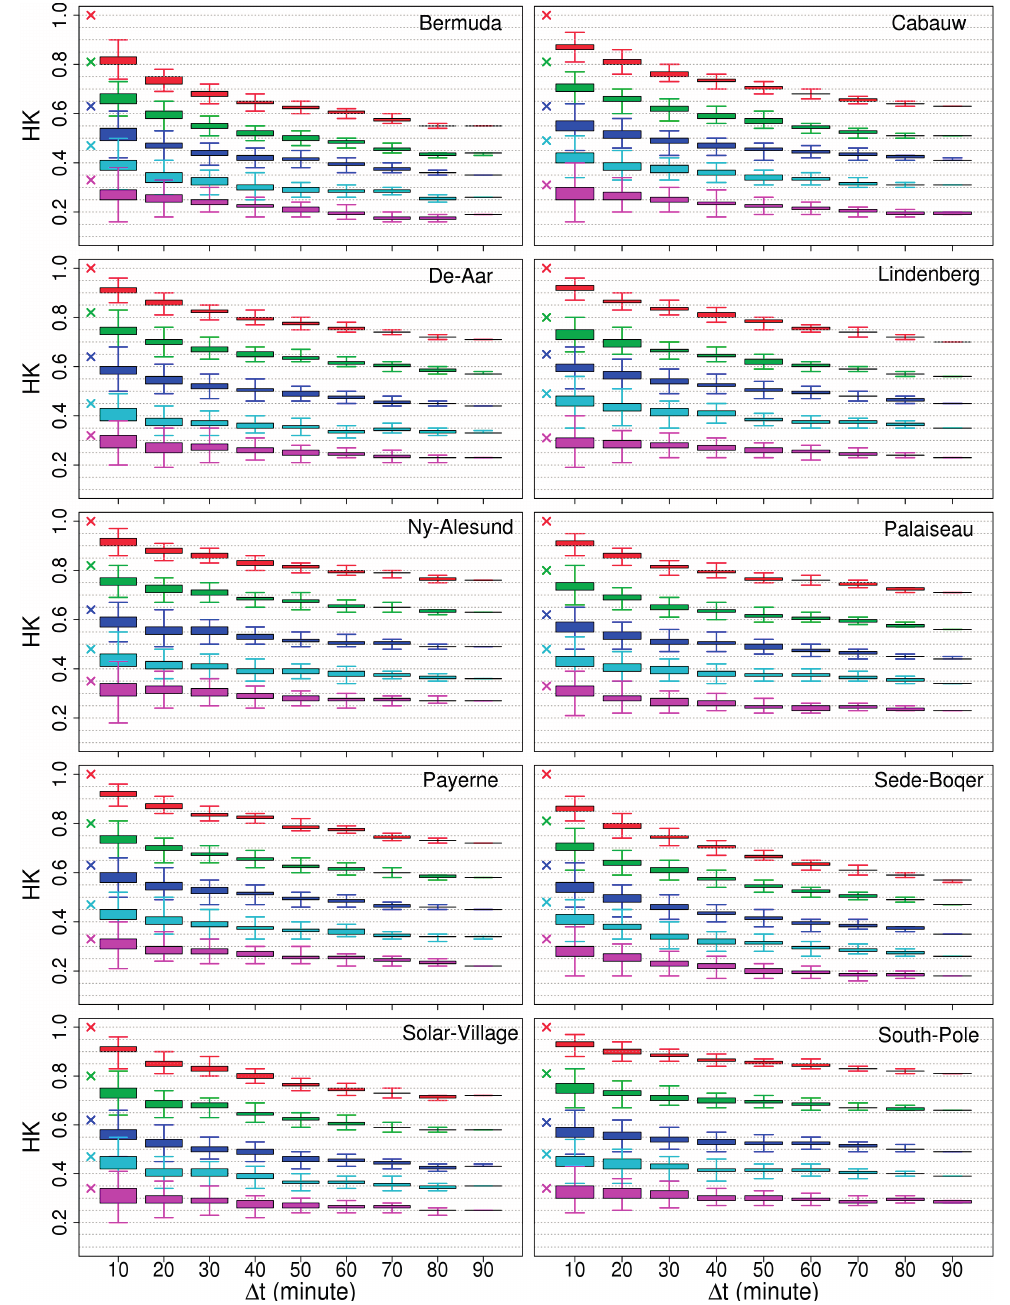
Figure 4. The validation results for the degraded time series with a varying maximum time difference between NOAA/AVHRR overpass and reference SYNOP observation ( Δ t ). The degraded time series (deg p , s ) are of the swapped time span (s) equal 12 h, and the percent of swapped observations ( p ) of: 0% (red), 10% (green), 20% (blue), 30% (cyan), and 40% (magenta). Each boxplot contains 500 values derived from the random selection of n samples from the total number of overpasses ( N = 7589). The unbiased skill score (HK 0 ) is marked with ×. The boxes identify the first and third quartiles, and the whiskers extend to the data